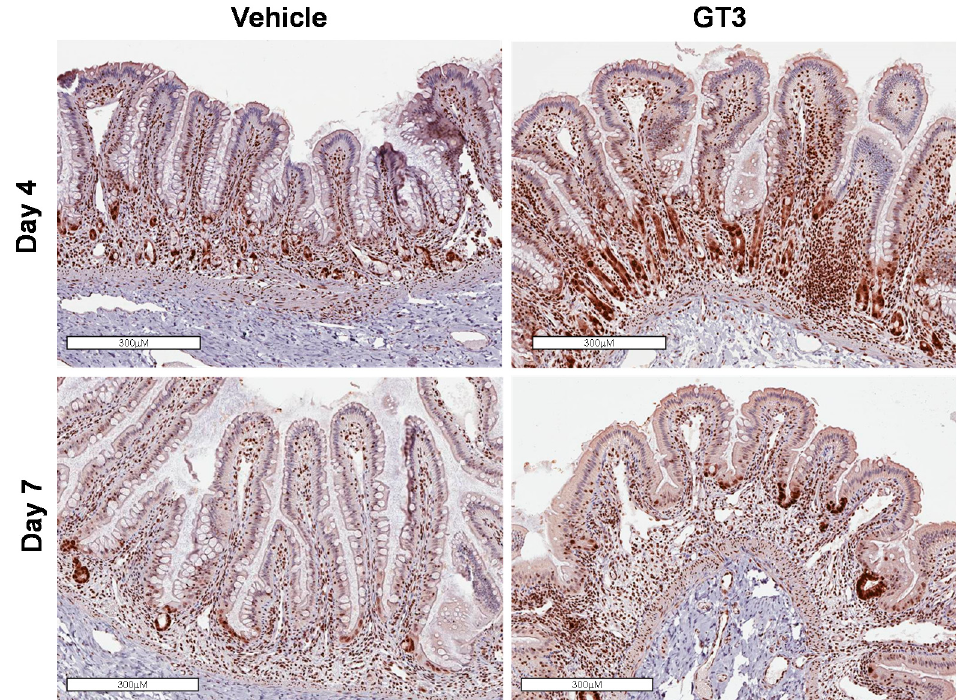
Figure 5. Effects of GT3 on PCNA expression in proximal jejunum post-irradiation . Representative images showing the expression of PCNA in cross sections of proximal jejunum treated with vehicle or GT3 prior to exposure to 12 Gy TBI at day 4 and day 7 post-irradiation.